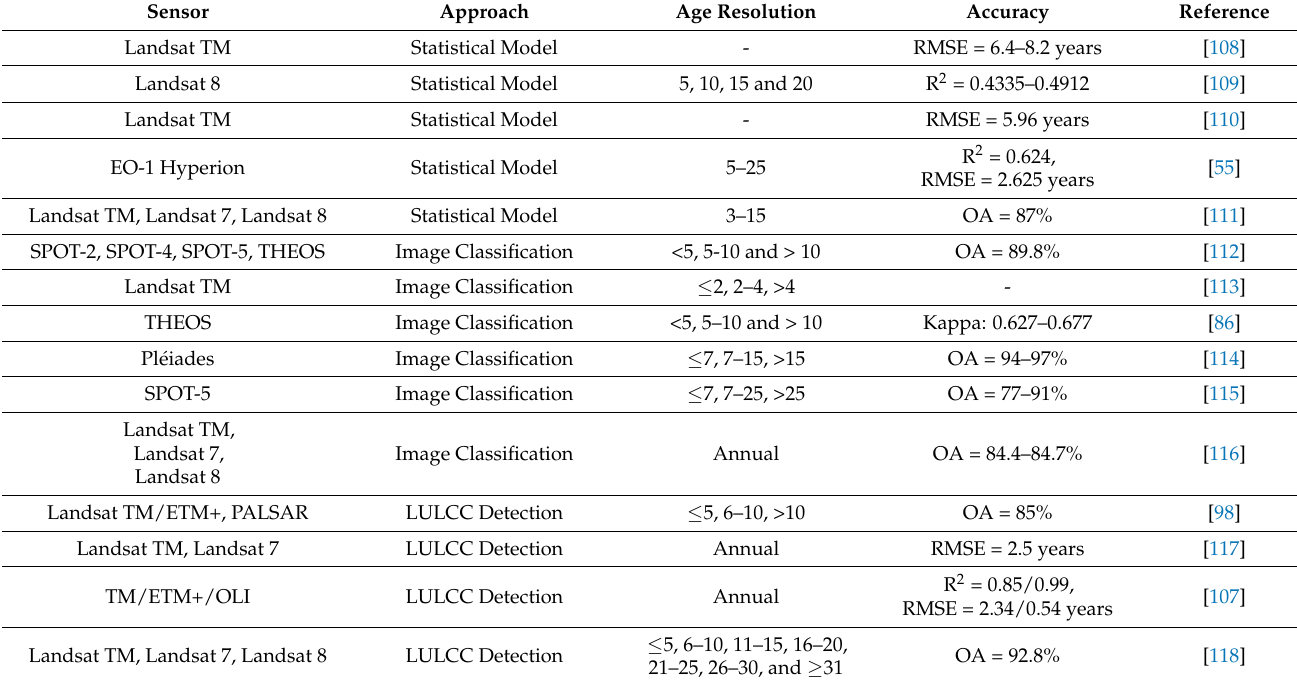
Table 6. Comparison of approach method, age resolution and accuracy in stand age estimation studies of rubber plantations.